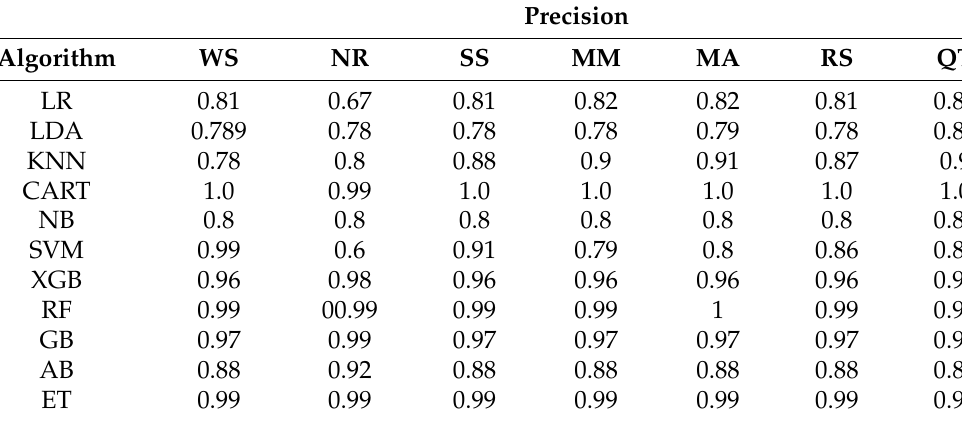
Table 6. Overall performance of different algorithms based on